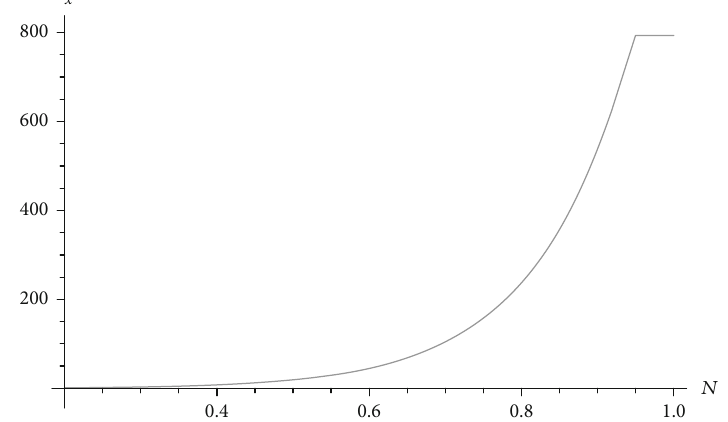
Figure 20: Shows the perturbations along the x -axis ( ϵ